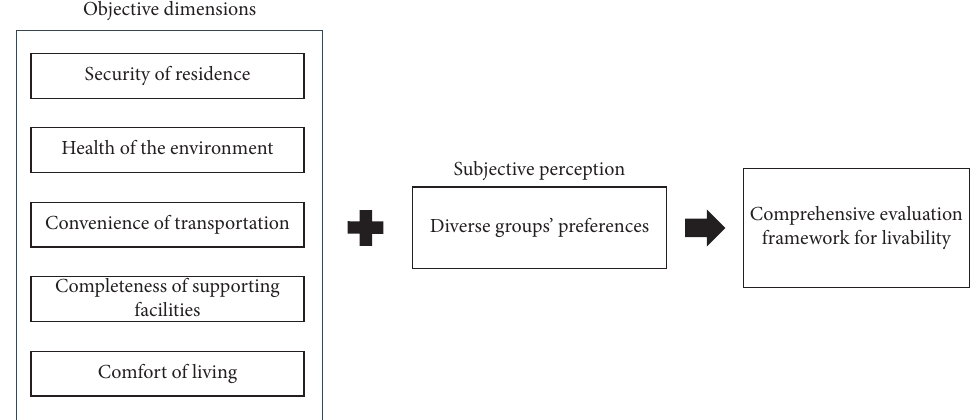
Figure 2: A comprehensive evaluation framework for livability at the community